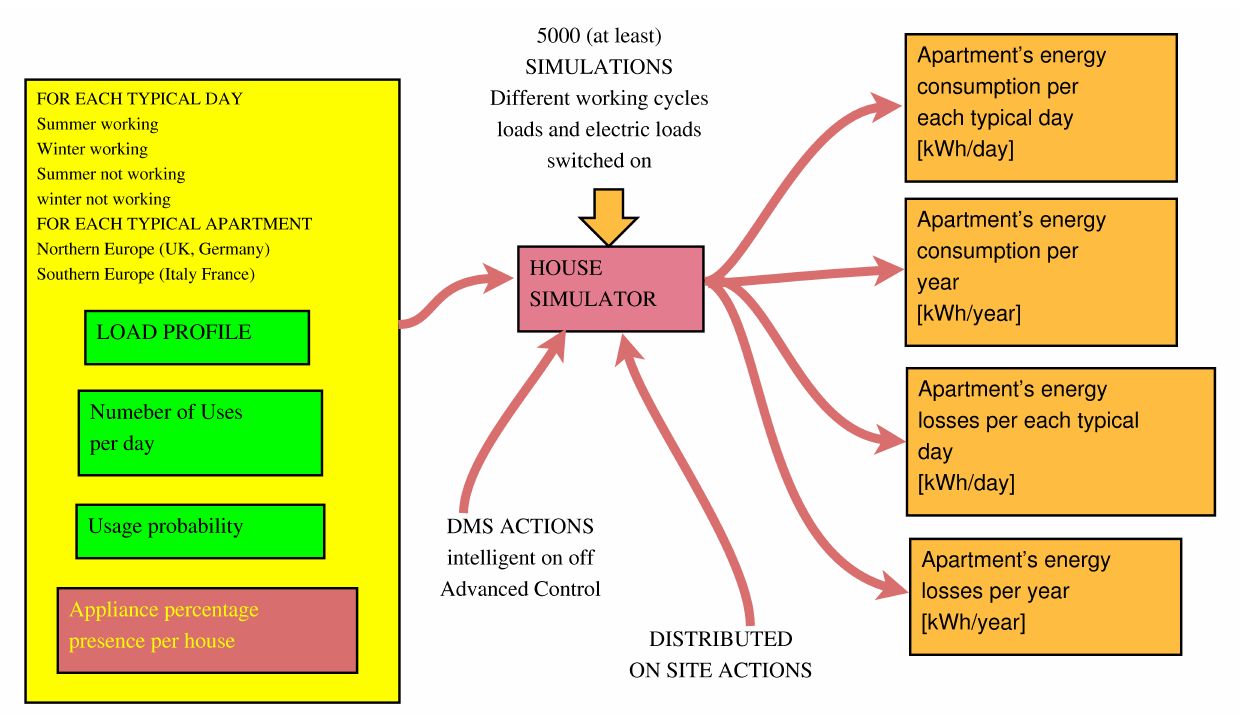
Figure 11. Input and data